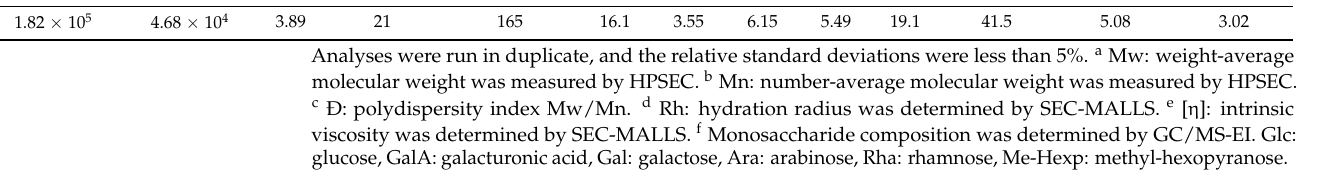
Figure 1. ATR-FTIR spectrum of CFPS.